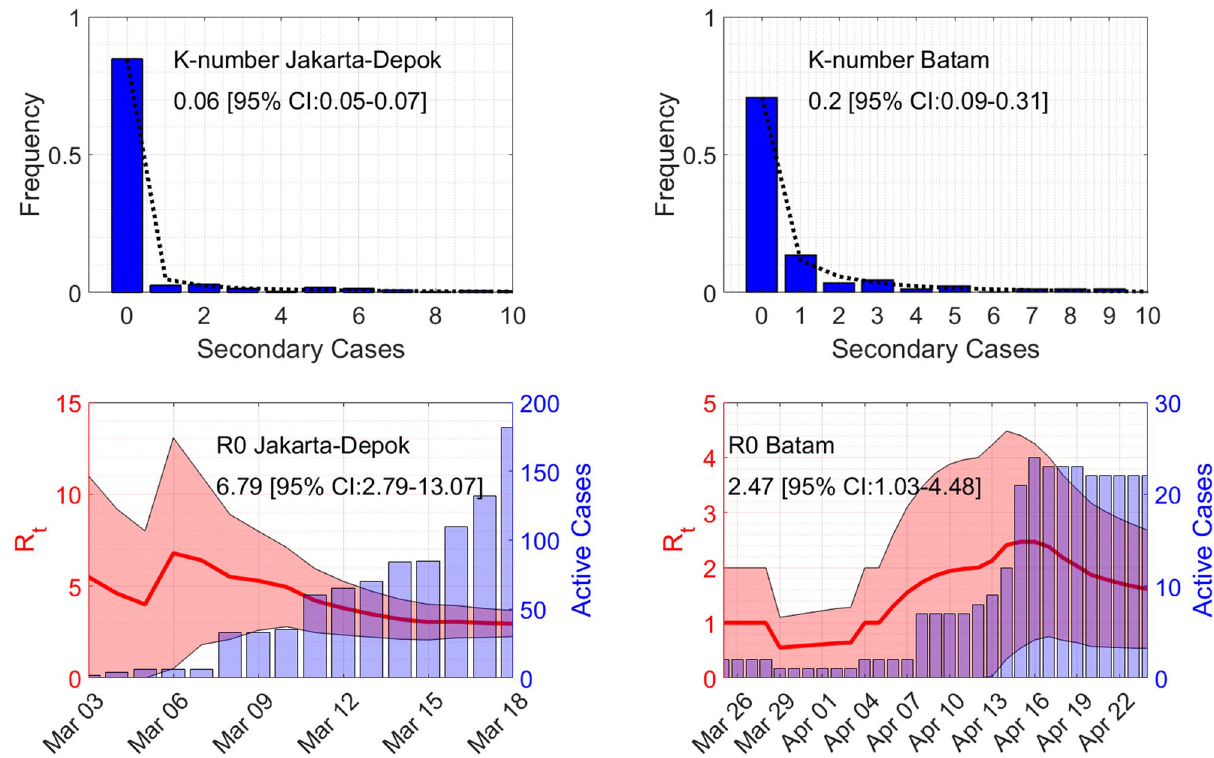
Figure 2. Estimates of the overdispersion parameter K and the basic reproduction number R 0 . Lines in the top figures show maximum-likelihood fits for the negative binomial